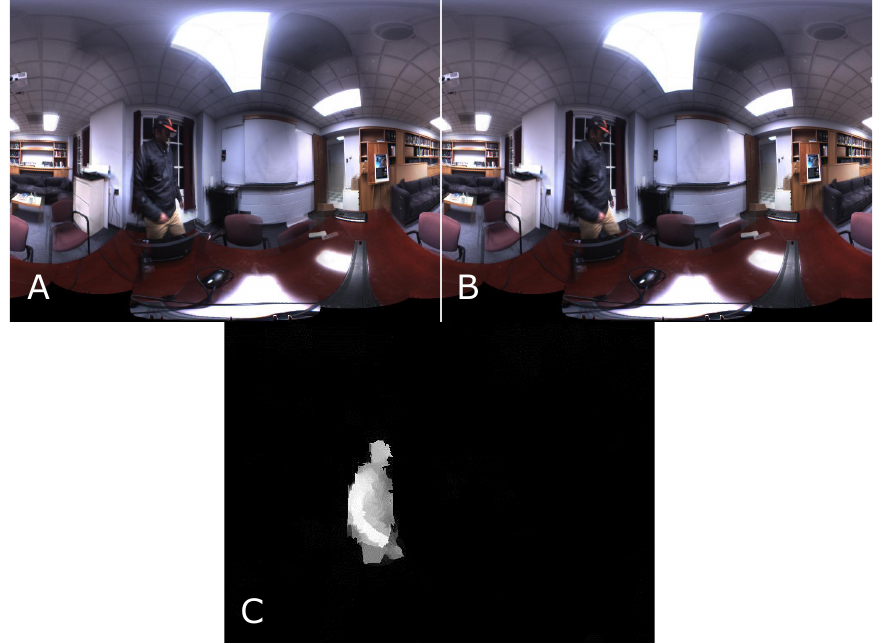
Figure 3. Computation of motion magnitude map: ( A ) a frame from the dataset; and ( B ) the successive frame. The person in the two frames is the only moving object in the two image frames, moving from left to right in the image. ( C ) The motion magnitude